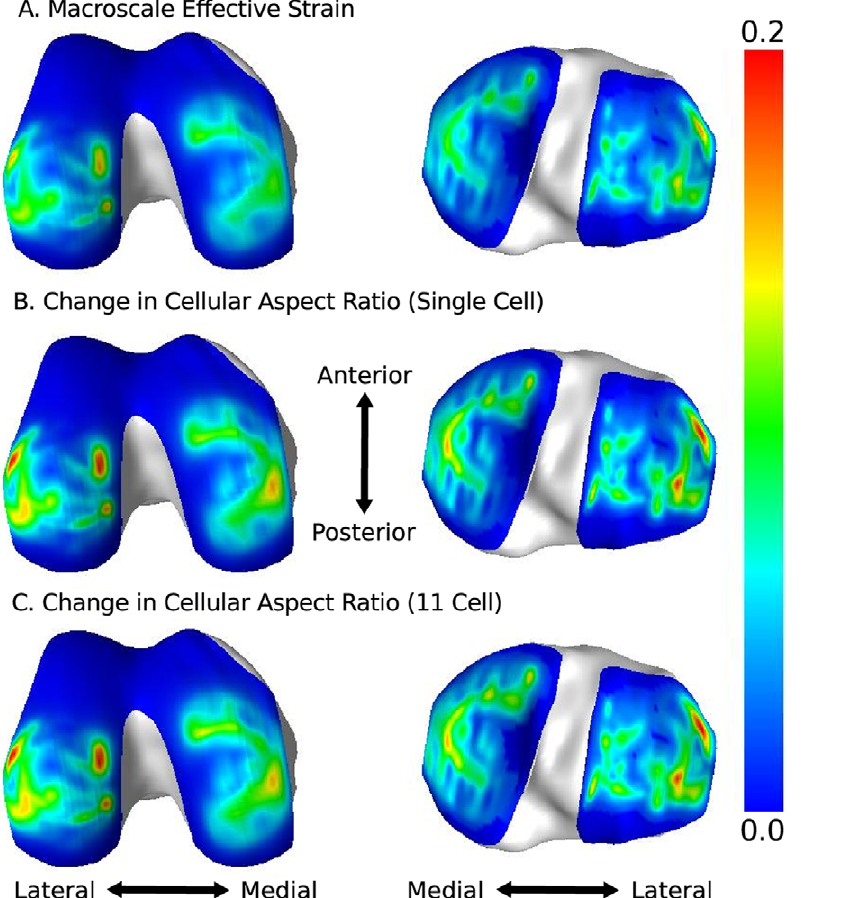
Figure 5. Fringe plots showing macro-scale and micro-scale deformation metric regional distributions in the middle layer of cartilage of the femur (left) and tibia (right). A . The effective strain which occurred at the macro-scale. B . The change in cellular aspect ratio (major-minor) calculated for the single cell model. C . The maximum change in cellular aspect ratio (major-minor) experienced by a cell in the 11 cell model.